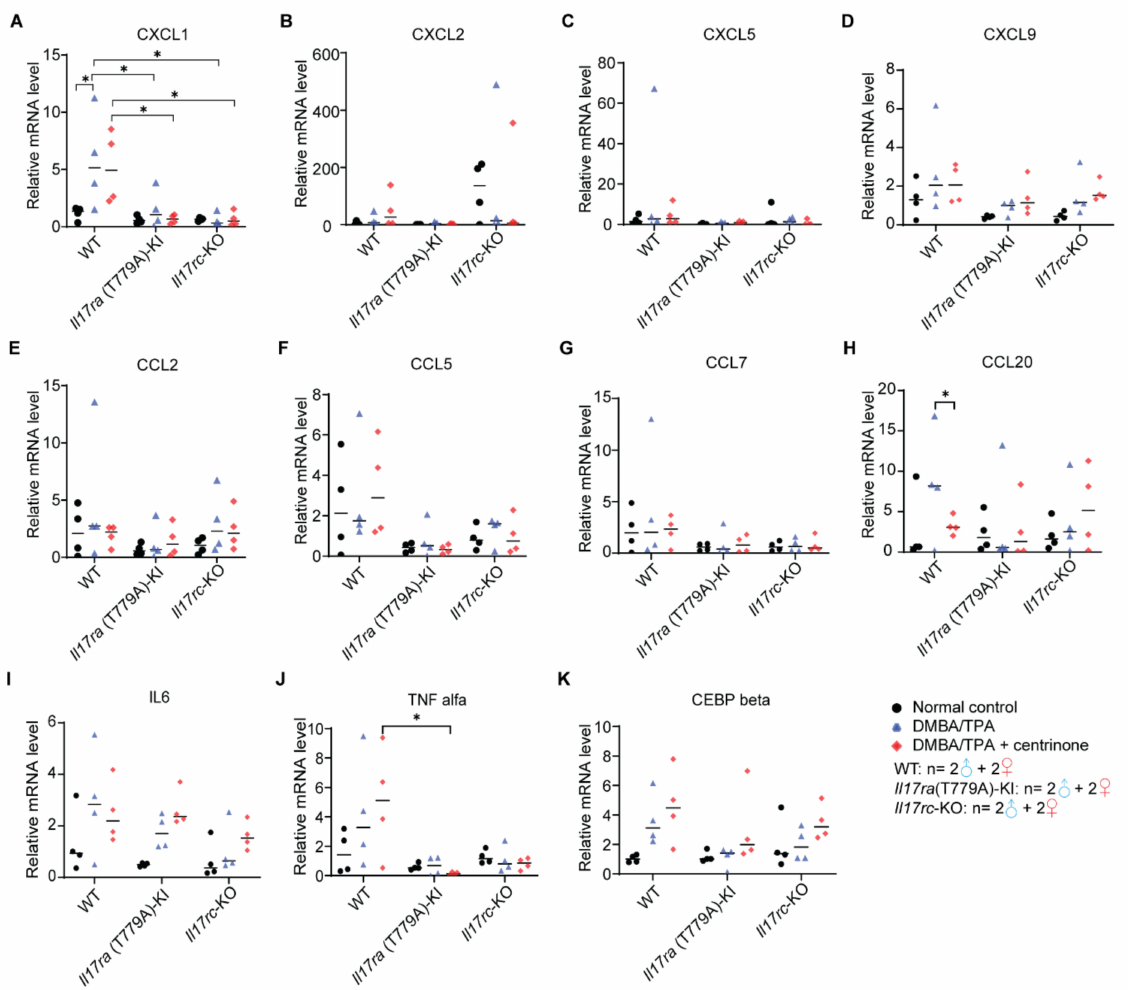
Figure 8. CXCL-mediated inflammatory response is inhibited in the papilloma model. Mouse skin was collected from 4 individuals of each genotype. Total RNA was isolated and the expression levels of CXCL1 ( A ), CXCL2 ( B ), CXCL5 ( C ), CXCL9 ( D ), CCL2 ( E ), CCL5 ( F ), CCL7 ( G ), CCL20 ( H ), IL6 ( I ), TNF α ( J ), and CEBP β ( K ) were evaluated by real-time PCR. Normalized value was presented as mean ± SD. Statistical significance was assessed by one-way ANOVA with Tukey’s multiple comparison test. *— p < 0.05. The number of male and female mice in each group are indicated in the